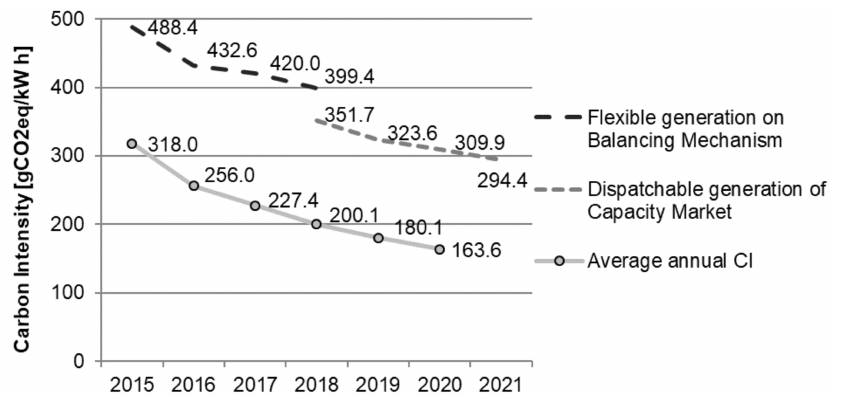
Figure 3. Carbon intensity of flexible generation on the BM and dispatchable generation secured in CM auctions, plotted against the average annual CI of the grid. The average annual value for 2020 is